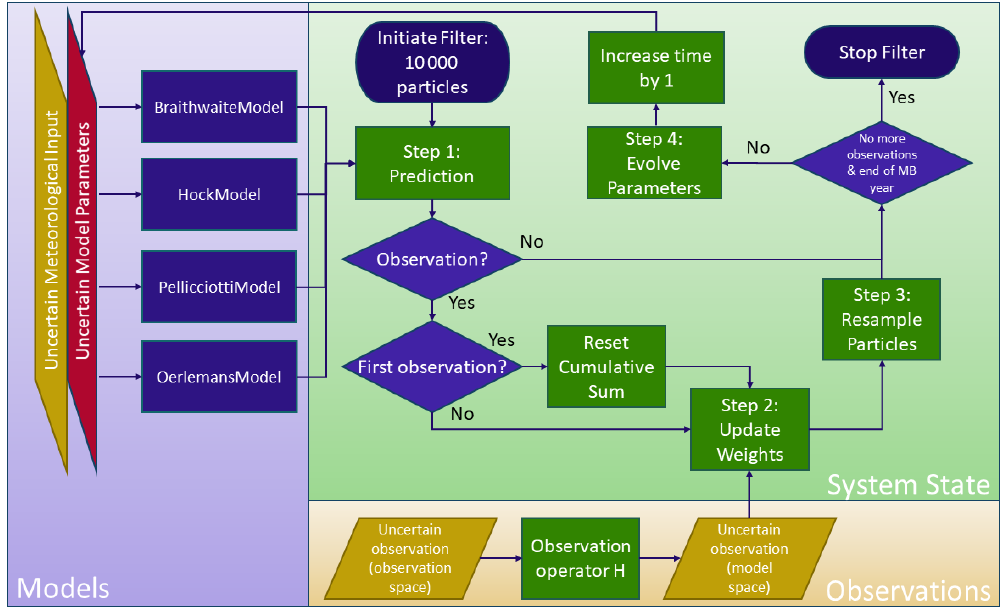
Figure 5. Particle filter workflow during 1 mass budget year (“MB year”). We use uncertain model estimates to predict mass balance with 10000 particles and reset the cumulative mass balance when a camera is set up. The model mass balance estimate is updated at time steps for which observations are available. To avoid overconfidence of the particle filter, we apply a partial resampling technique. The individual particle filter steps are sketched in Fig. 6.